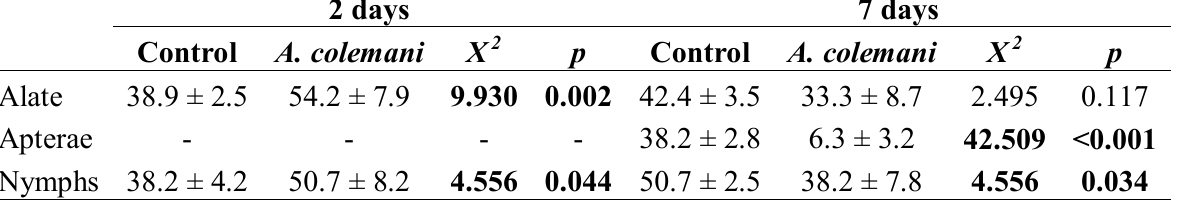
Table 2. Mean ± S.E. percentage of test plants occupied by one or more alate, apterae or nymphs (occupancy rate) in CMV-infected source plant assays after 2 and 7 days in cages with and without (control) A. colemani . Means in the same row followed by statistics in bold are significantly different according to a Chi-square 2 × 2 goodness of fit test ( p < 0.05).